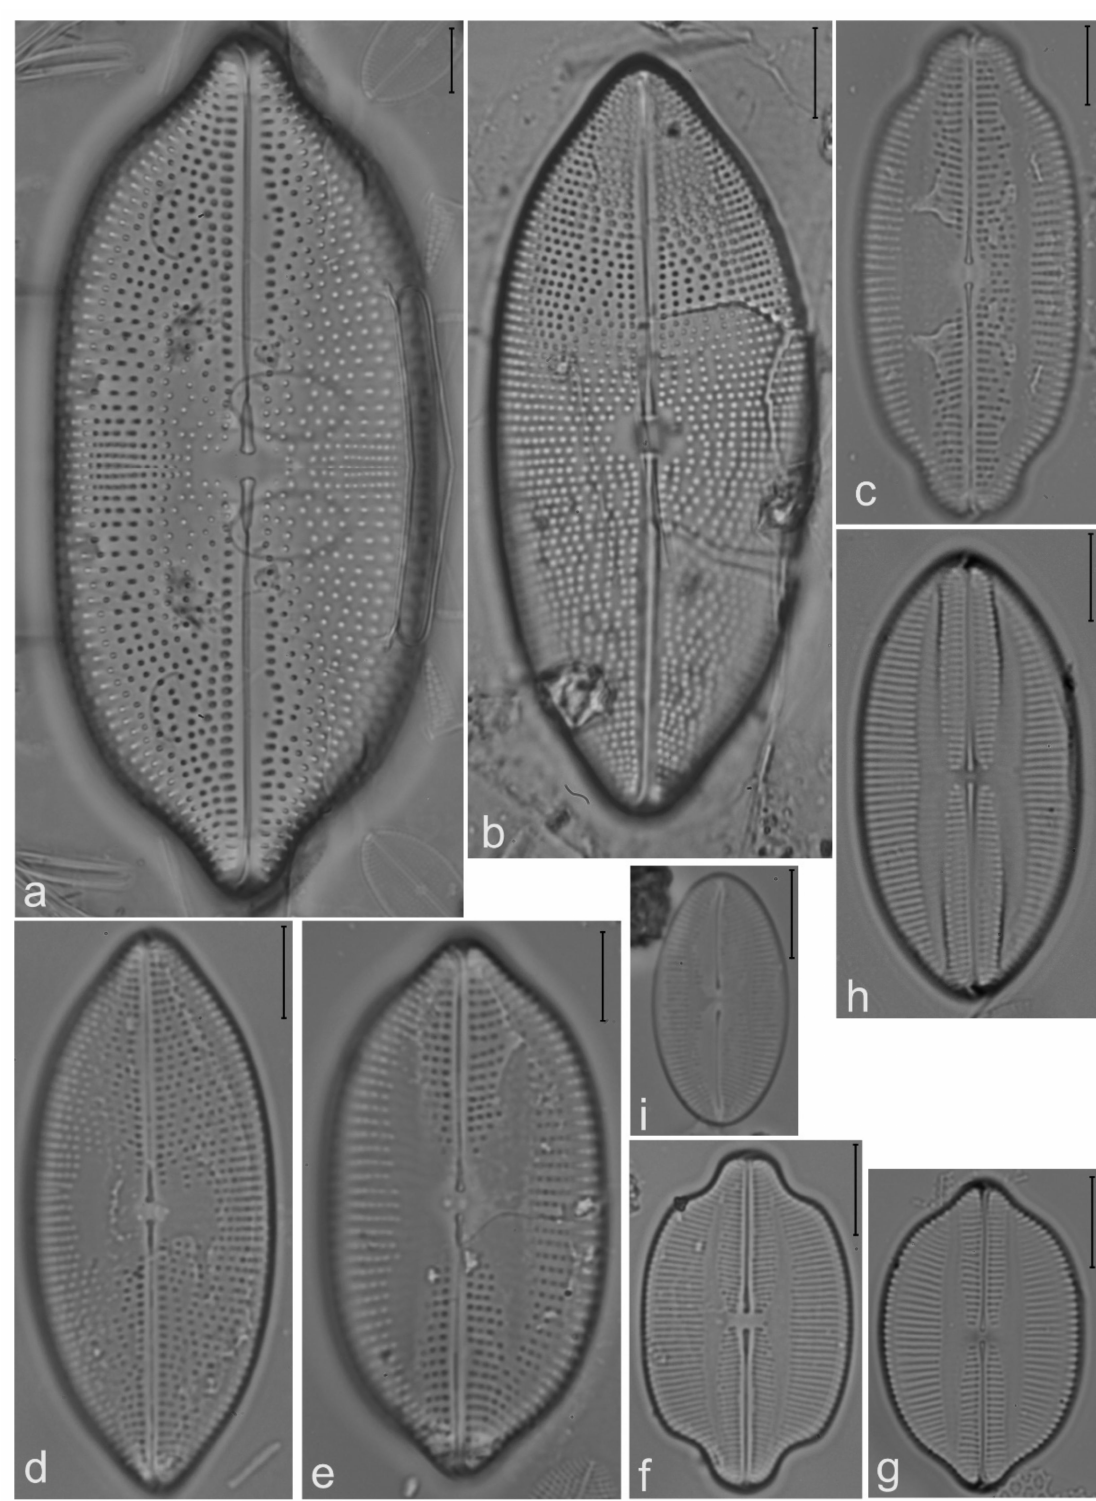
Figure 25. ( a ) Petroneis subdiffusa ; ( b ) P . granulata ; ( c ) Lyrella diffluens ; ( d ) Petroneis plagiostoma ; ( e ) L . approximatoides ; ( f ) L . barbara var. densestriata ; ( g ) L . barbara ; ( h ) L . excavata ; ( i ) Fallacia vittata . Scale bar = 10 µ